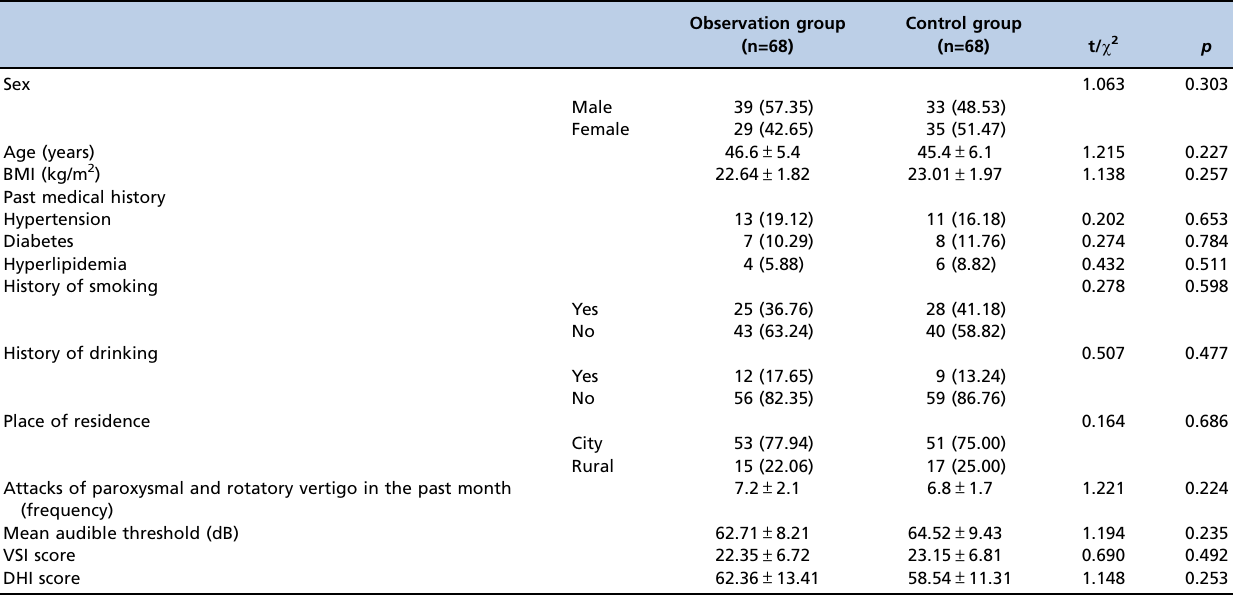
Table 2 - Clinical data [n (%)].